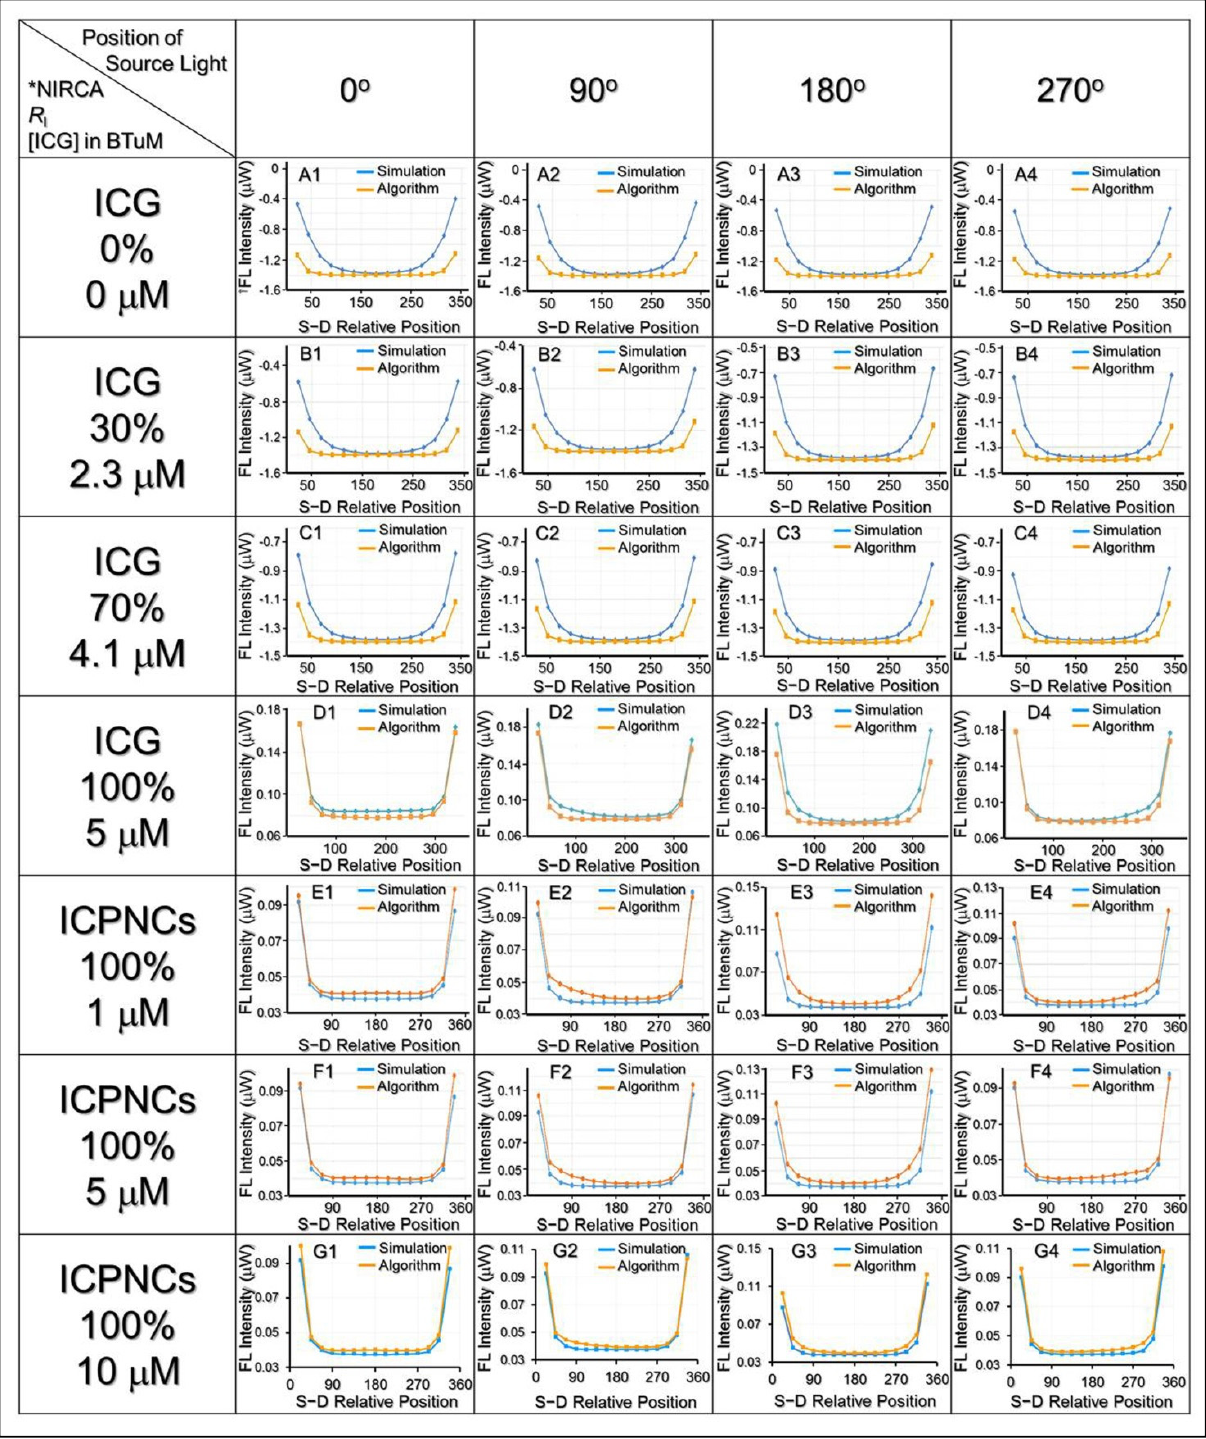
Figure 4. Analyses of FDOT fluorescence signals using free ICG or ICPNCs as the contrast agent in phantom study. Rows A–D represent the groups using free ICG with R I = 0%, 30%, 70%, and 100%, while E–G denote the groups using ICPNCs containing 1, 5, and 10 μ M of ICG with R I = 100% as indicated in the figure. Columns 1–4 denote the positions of the source light as illustrated in Figure 1(bII). The fluorescence intensities expressed from various positions were analyzed using both simulated and algorithmic approaches. The FDOT was performed using an NIR laser with an intensity of 30 mW and the integration time was set as 800 ms. * NIRCA denotes NIR contrast agent. † FL represents fluorescence.